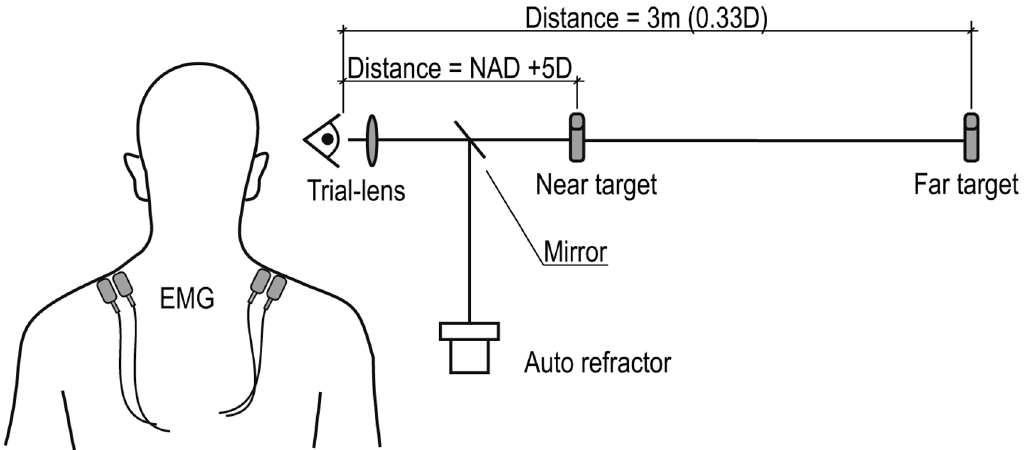
Fig 1. The laboratory set-up. This is a schematic illustration of the experimental set-up in the laboratory. The distance to the Far target was 3 m (0.33 D) for all subjects. The distance to the near target was individually adjusted to be 5 D away from each individual ’ s near point of accommodation (NAD + 5 D). D =